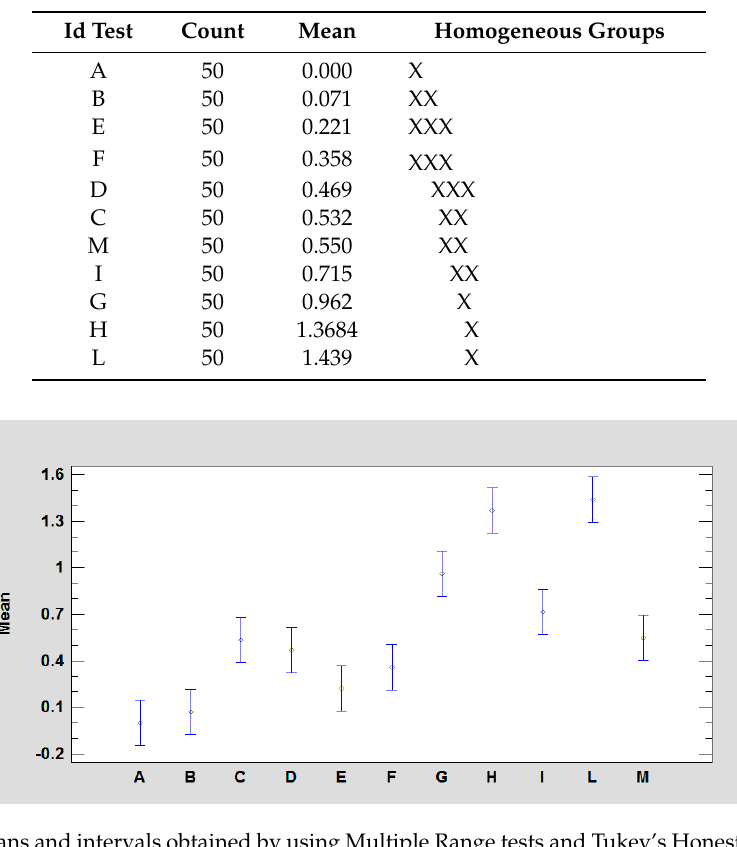
Figure 5. Means and intervals obtained by using Multiple Range tests and Tukey’s Honestly Significant Difference (HSD) test at 95.0% confidence level. Table 5. Estimated di ff erence between each pair of means and statistically significant di ff erences at 95.0% confidence level 1